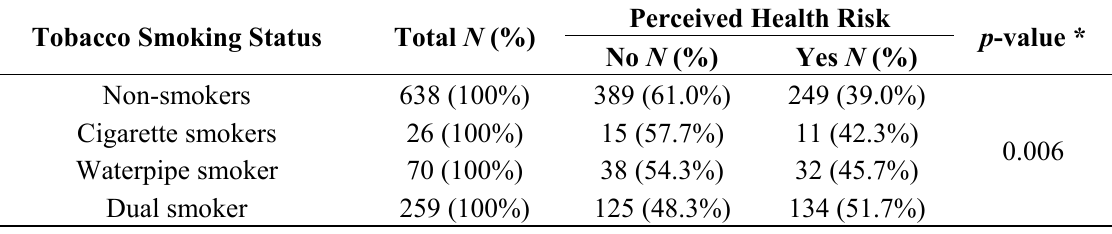
Table 3. Association between participants’ perceived health risk and tobacco smoking status. Tobacco Smoking Status